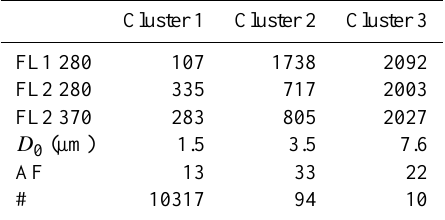
Table 3. Cluster averages for the WIBS3 dataset. Bottom row shows the number of constituent measurements. FL1 280, FL2 280 and FL2 370 are the intensities in each channel, respectively (arbitrary units). Cluster 1 Cluster 2 Cluster